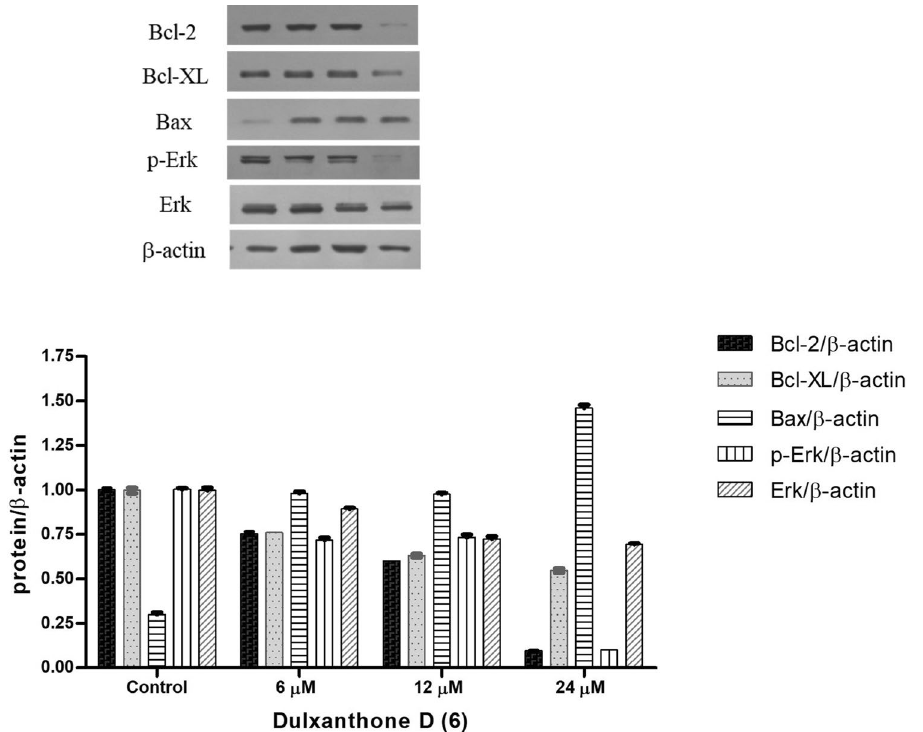
Figure 5. Effect of dulxanthone D ( 6 ) on Erk and Bcl-2 family